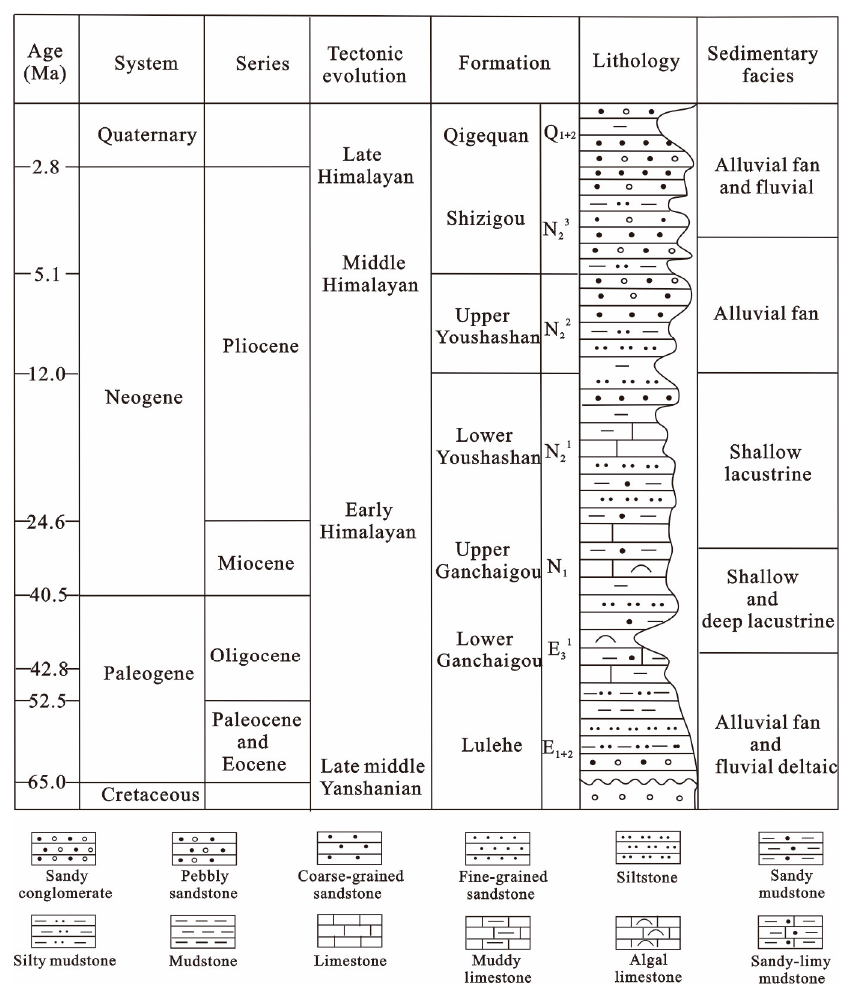
Figure 2. Generalized stratigraphic column for the northwesternQaidam Basin.Figure after Feng [26].